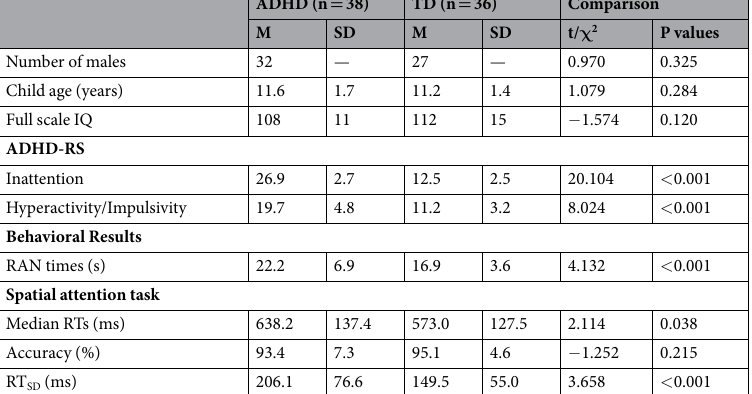
Figure 2a and b show ERP waveforms in response to visual search arrays from electrodes over the visual cortex contralateral and ipsilateral to the target (PO7 and PO8). As can be seen clearly, a robust P1 component was elicited during 100–130 ms post-stimulus in both groups. For the P1 amplitudes (102–122 ms),